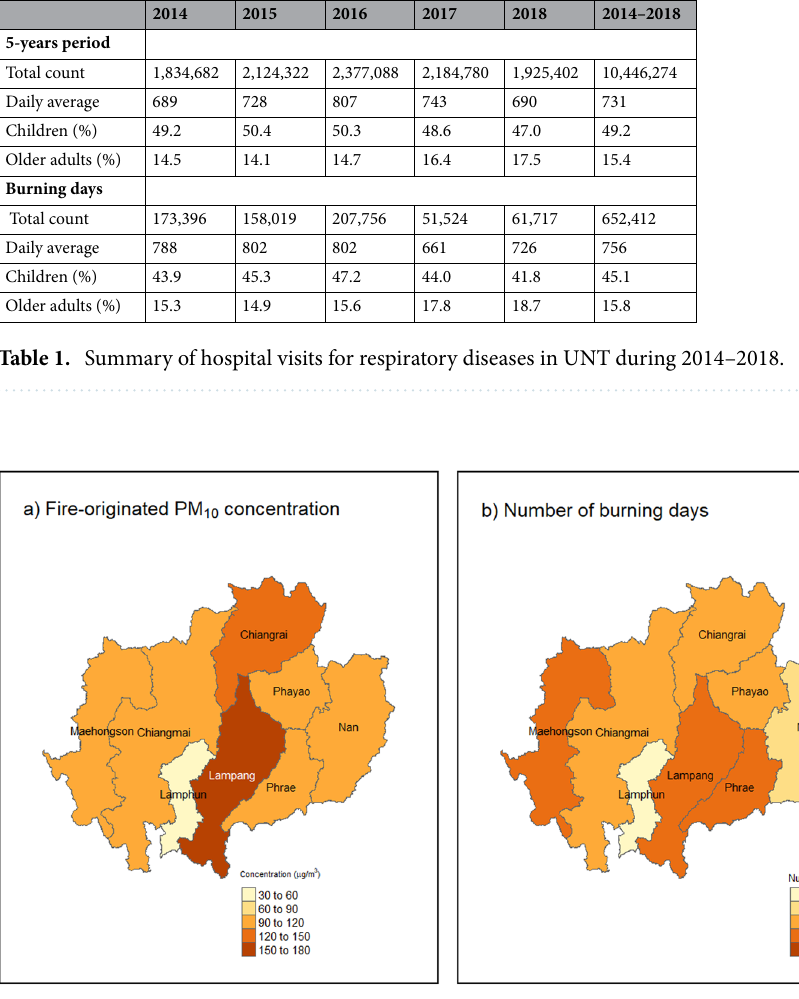
Figure 1. Average fire-originated PM 10 concentration (μg/m 3 ) and total number of burning days. Map was generated using the package “ raster ” 46 and “ tmap ” 47 of R (version 4.1.3, The R Foundation for Statistical Computing, Vienna,